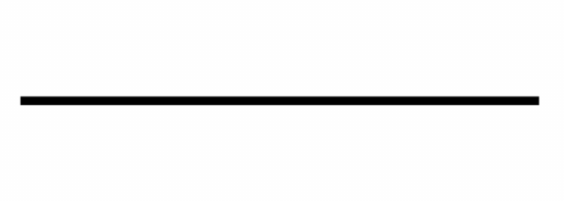
Figure 1 . Leading order.